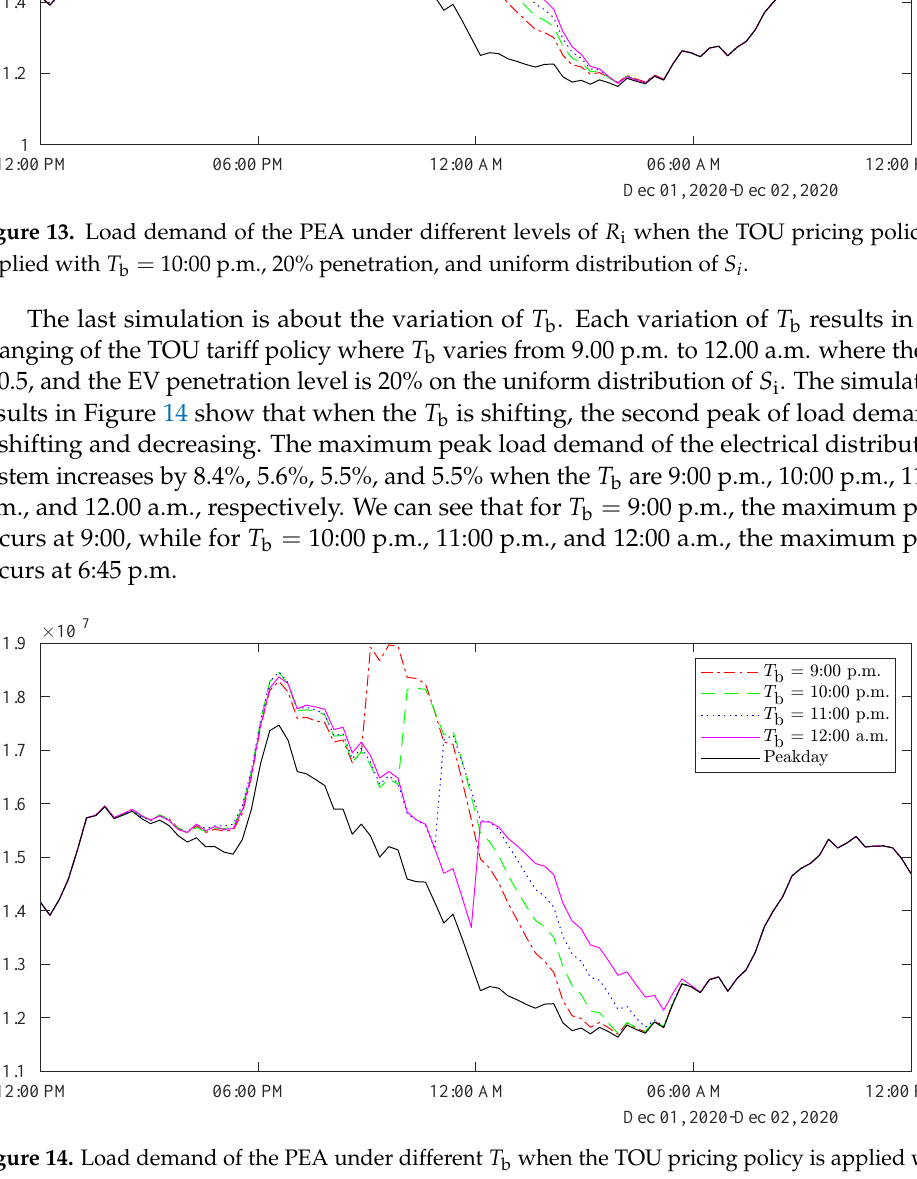
Figure 14. Load demand of the PEA under different T b when the TOU pricing policy is applied with R i = 0.5, 20% penetration, and uniform distribution of S i